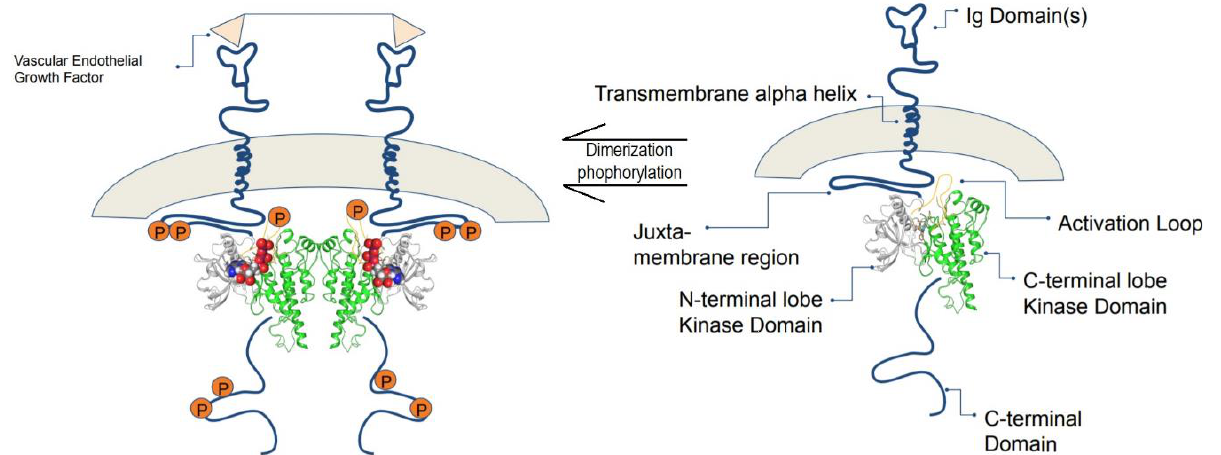
Figure 4. The composition of VEGFR consists of seven immunoglobin-like motifs. VEGF binds to the extracellular domain, and VEGFRs dimerize, leading to a conformational change that is transmitted across the membrane, which leads to activation. Adapted from Schrodinger tutorials [86]. According to the pattern of conformations, the protein tyrosine kinase inhibitors are classified into 4 types: Type I, Type II, Type III, and Type IV [87]. The competitive Type I and II enzyme inhibitors, which interact with ATP-binding pocket and Mg2+ ion in the